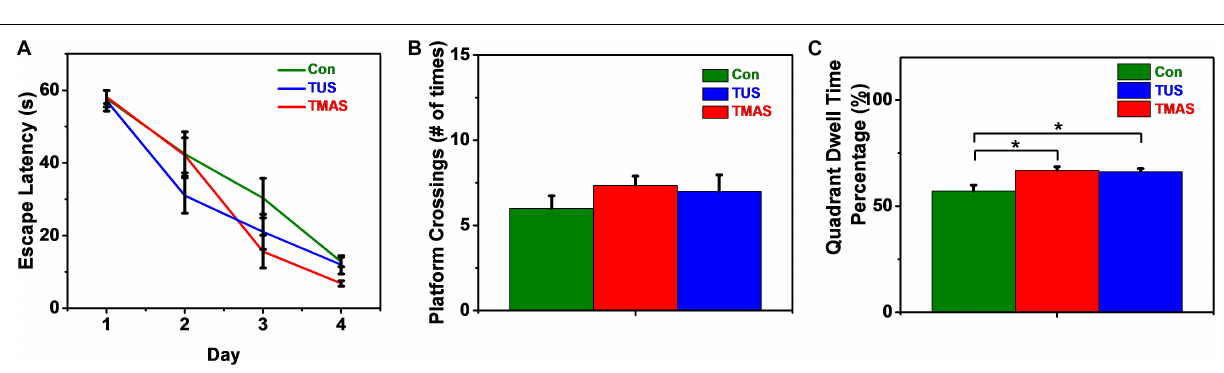
group (7.00 ± 0.97) and more than the Con group (6.00 ±